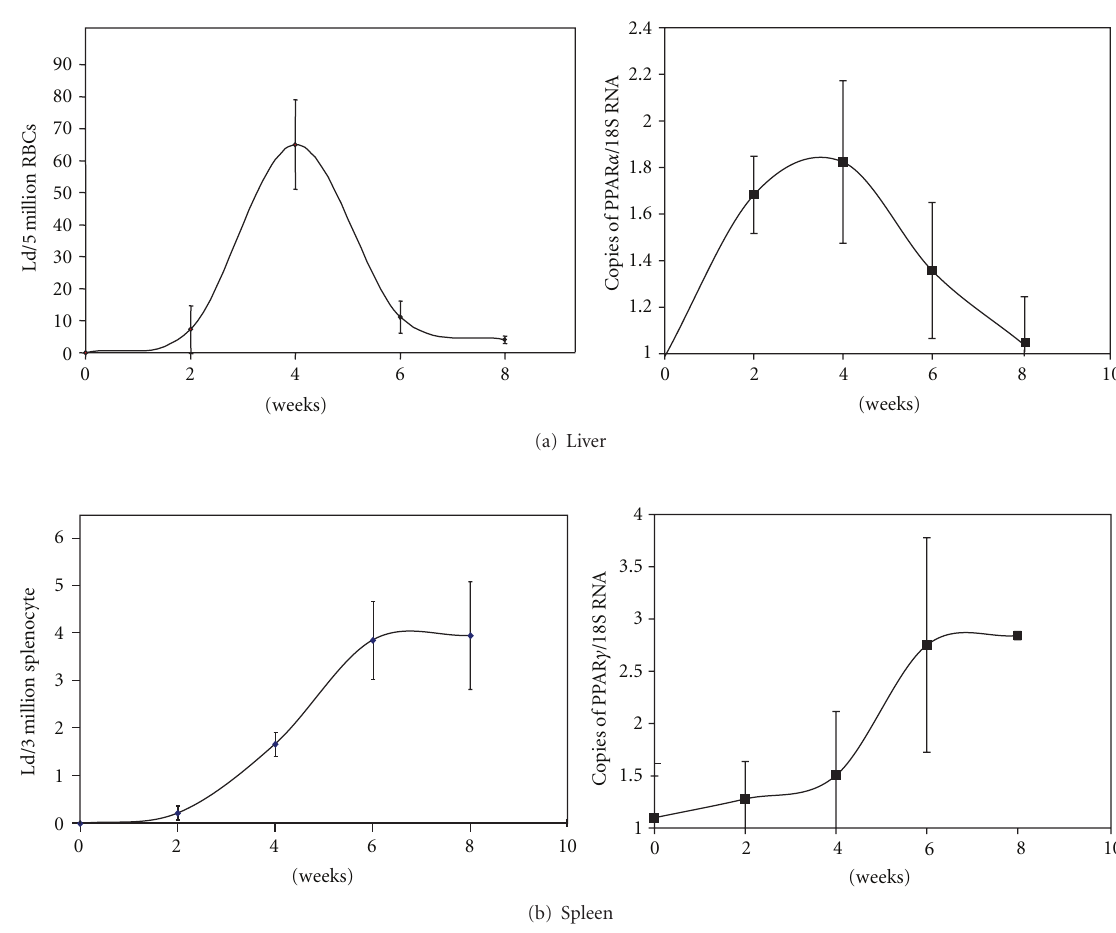
Figure 2: Kinetics of PPAR expression and parasitic infection. BALB/c mice were intravenously injected with 10 7 stationary phase promastigotes of L. donovan i 1S. At two-week intervals, groups ( n = 5) were sacrificed, and their liver and spleen were harvested. PPAR expression was determined by real-time RT-PCR as described in legend of Figure 1. The amount of parasites in the organs was determined by limiting dilution analysis according to the procedure of Titus and colleagues [17]. Cells were plated into wells of 96-well plates at a range of concentrations, according to the number of red blood cells in the liver and splenocytes in the spleen suspensions and then incubated at 27 ◦ C to allow the parasites to transform from intracellular amastigotes into promastigotes. After 2-3 weeks of proliferation, the number of wells that shows parasite growth was scored under a microscope, and the L-Calc software for limiting dilution analysis (provided by Stem Cell Technology, Vancouver, Canada) was used to determine the frequency of parasite. Normalization was based on the number of red blood cells in the liver cultures (a) and the number of splenocytes in the spleen cultures